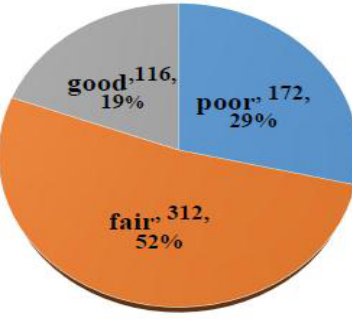
Figure 4: shows the distribution of studied sample according to social relationship. The higher number of parents reported fair social relationship.